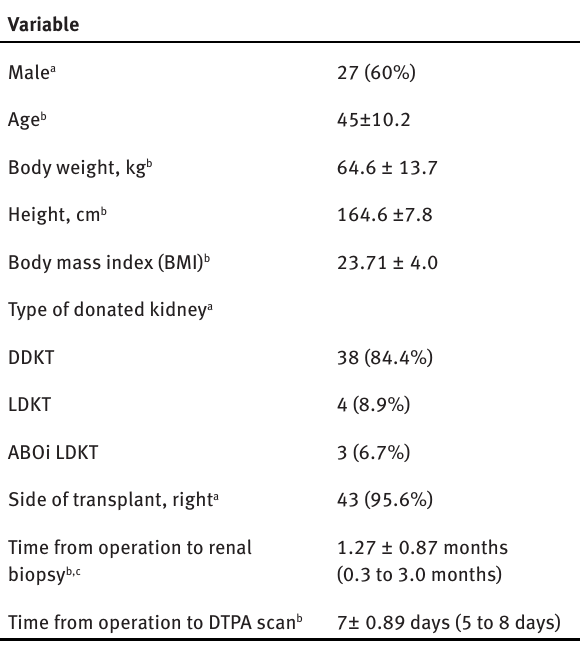
Table 1: Patient characteristics at the time of renal scan